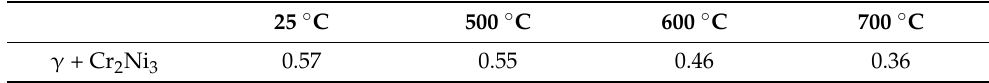
Figure 3. SEM images of rNi60/2.0% CeO 2 composite coating after Binary Treatment with different thermal treatment temperatures. ( a ) 25 °C; ( b ) 500 °C; ( c ) 600 °C; ( d ) 700 °C. Table 3. The volume fraction of eutectic structure at different temperatures.